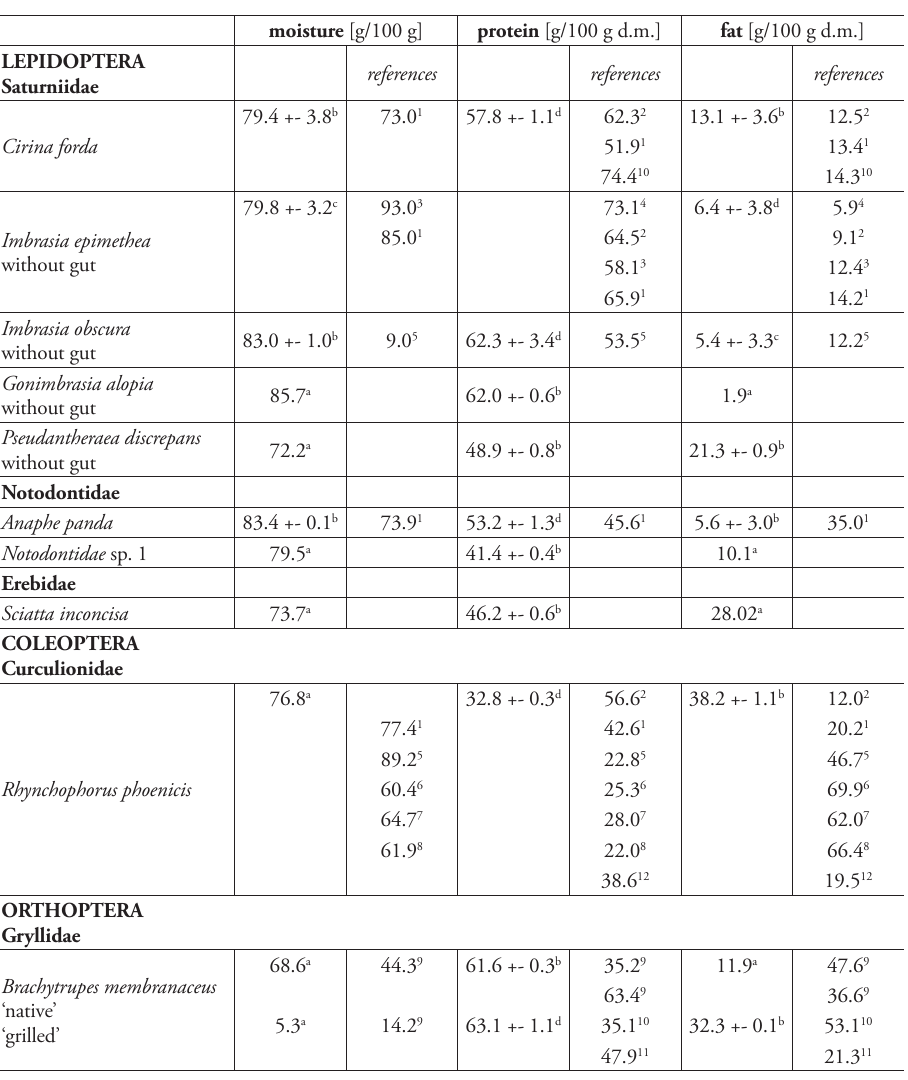
Table 4. Composition of major nutrients. Values per 100 g dry matter, moisture per 100 g fresh weight; in- dices give the number of analyses a single, b double, c triple, d quadruple, e sextuple; d.m.: dry matter, 1 : Malaisse and Parent 1980, 2 : Adriaens 1953, 3 : Kokondi et al. 1987, 4 : Lautenschläger et al. 2017, 5 : Santos Oliveira et al. 1976, 6 : Idolo 2010, 7 : Edijala et al. 2009, 8 : Ekpo 2010 and 2011, 9 : Mbemba 2013 (sun or oven dried), 10 : Agbiye 2009 (oven dried samples), 11 : Yhoung-Aree 1997, 12 : Okaraonye and Ikewuchi 2008. moisture [g/100 g] protein [g/100 g d.m.] fat [g/100 g